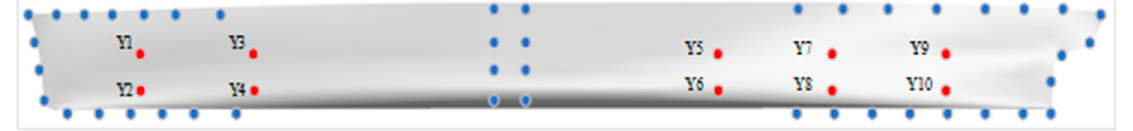
Figure 4. Distributions of variable and fixed points on the Series 60 hull surface (blue: fixed points; red: variable points). Table 1. S60 variation ranges of variables.